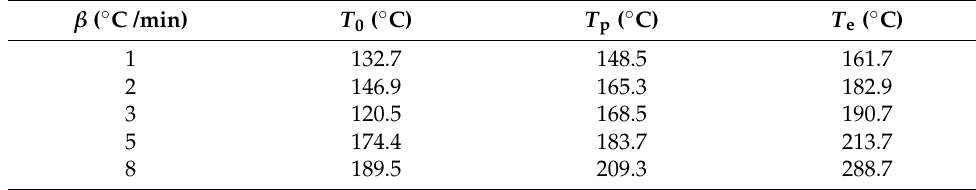
Figure 5. DSC curves of PSS + (NH 4 ) 2 SO 4 at five different β . Table 2. Characteristic temperature of PSS + (NH 4 ) 2 SO 4 in the DSC at different β .